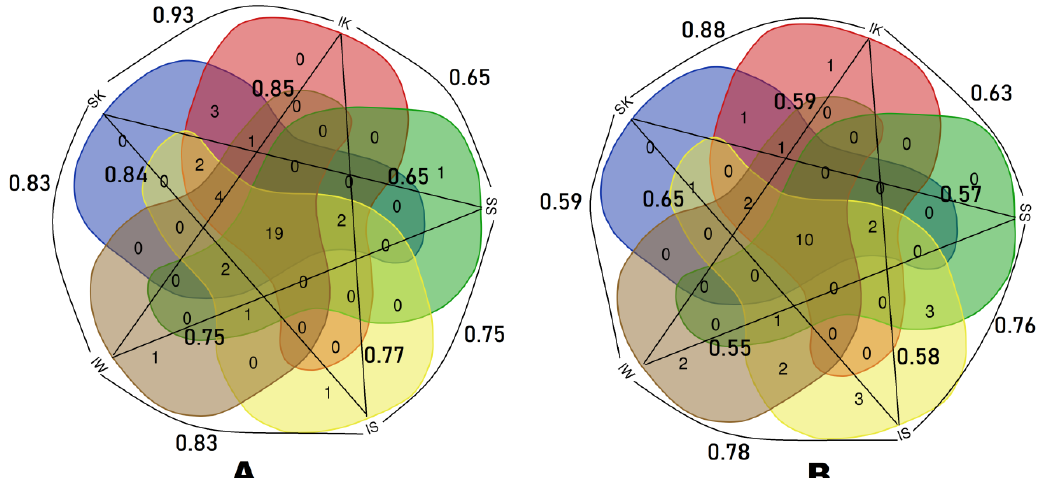
Figure 7. Venn diagrams showing Jaccard indexes and the overlap of ( A ) overall recorded wild food plants and ( B ) the most frequently reported wild food plants (quoted by more than 50% of the informants) among the five studied groups (IK: Ismaili Kho, IS: Ismaili Shina, IW: Ismaili Wakhi, SK: Sunni Kho, SS: Sunni Shina) in the Ishkoman Valley.